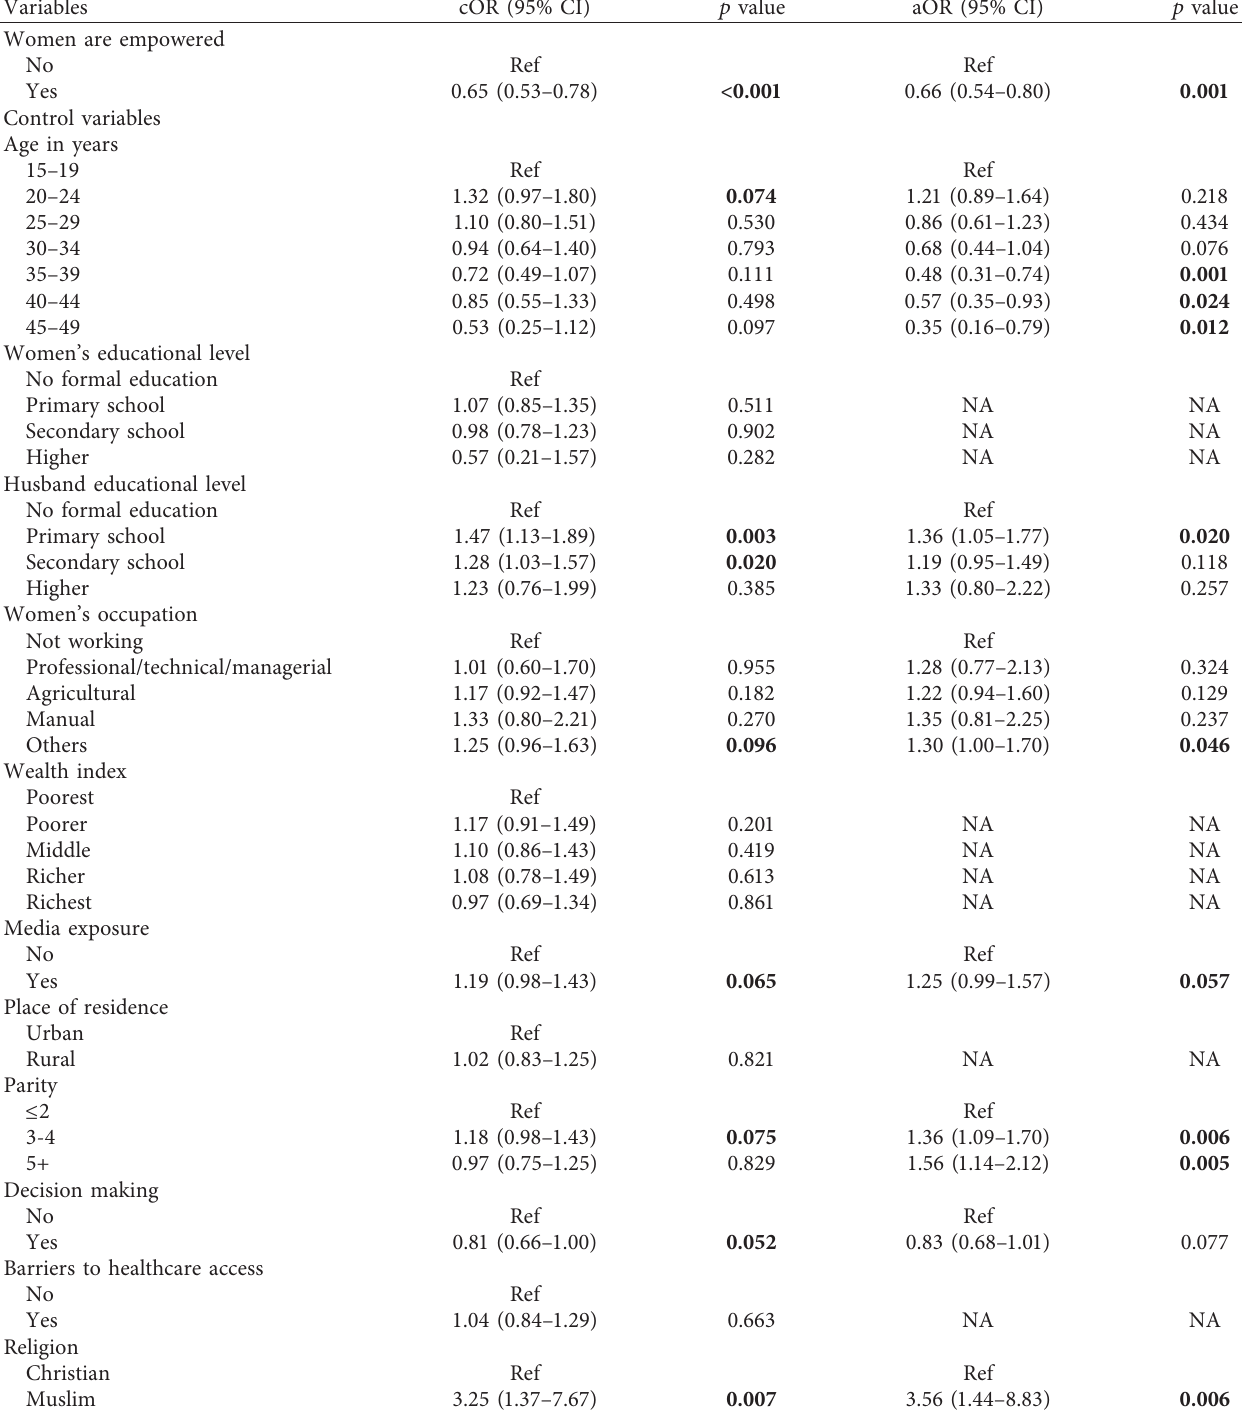
Table 3: Association between wife beating attitude and childhood diarrhea among married women: evidence from 25 SSA countries.